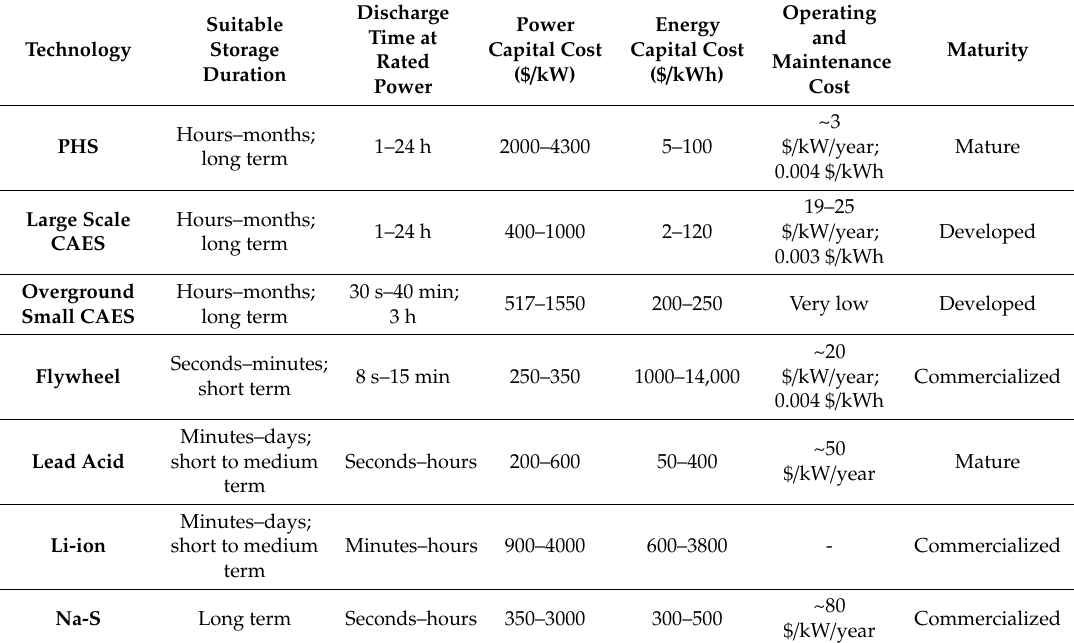
Table 16. Comparison of the technical parameters of di ff erent energy storage systems—III